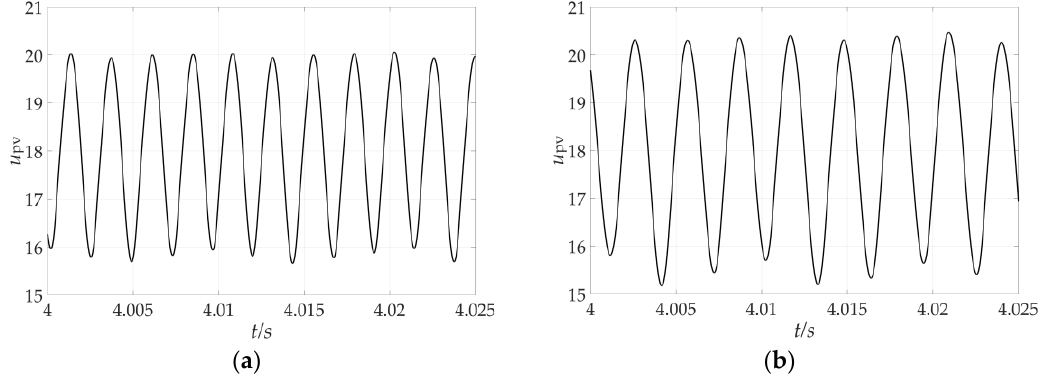
Figure 6. Waveform of u pv when ( a ) K p 1 = 0.11, T i 1 = 0.001; ( b ) K p 1 = 0.05, T i 1 = 0.001.